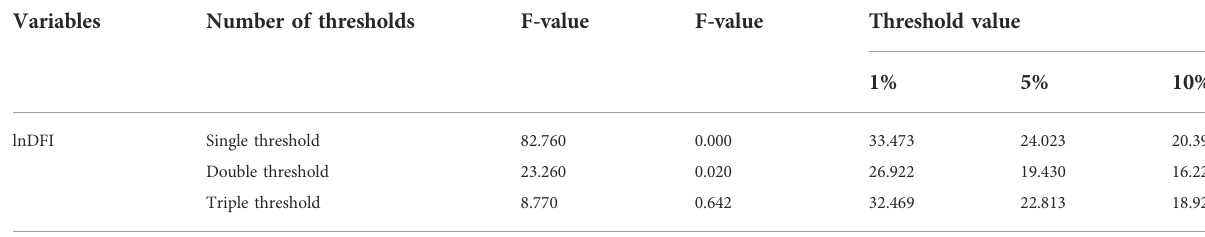
TABLE 8 Results of the threshold effect test.